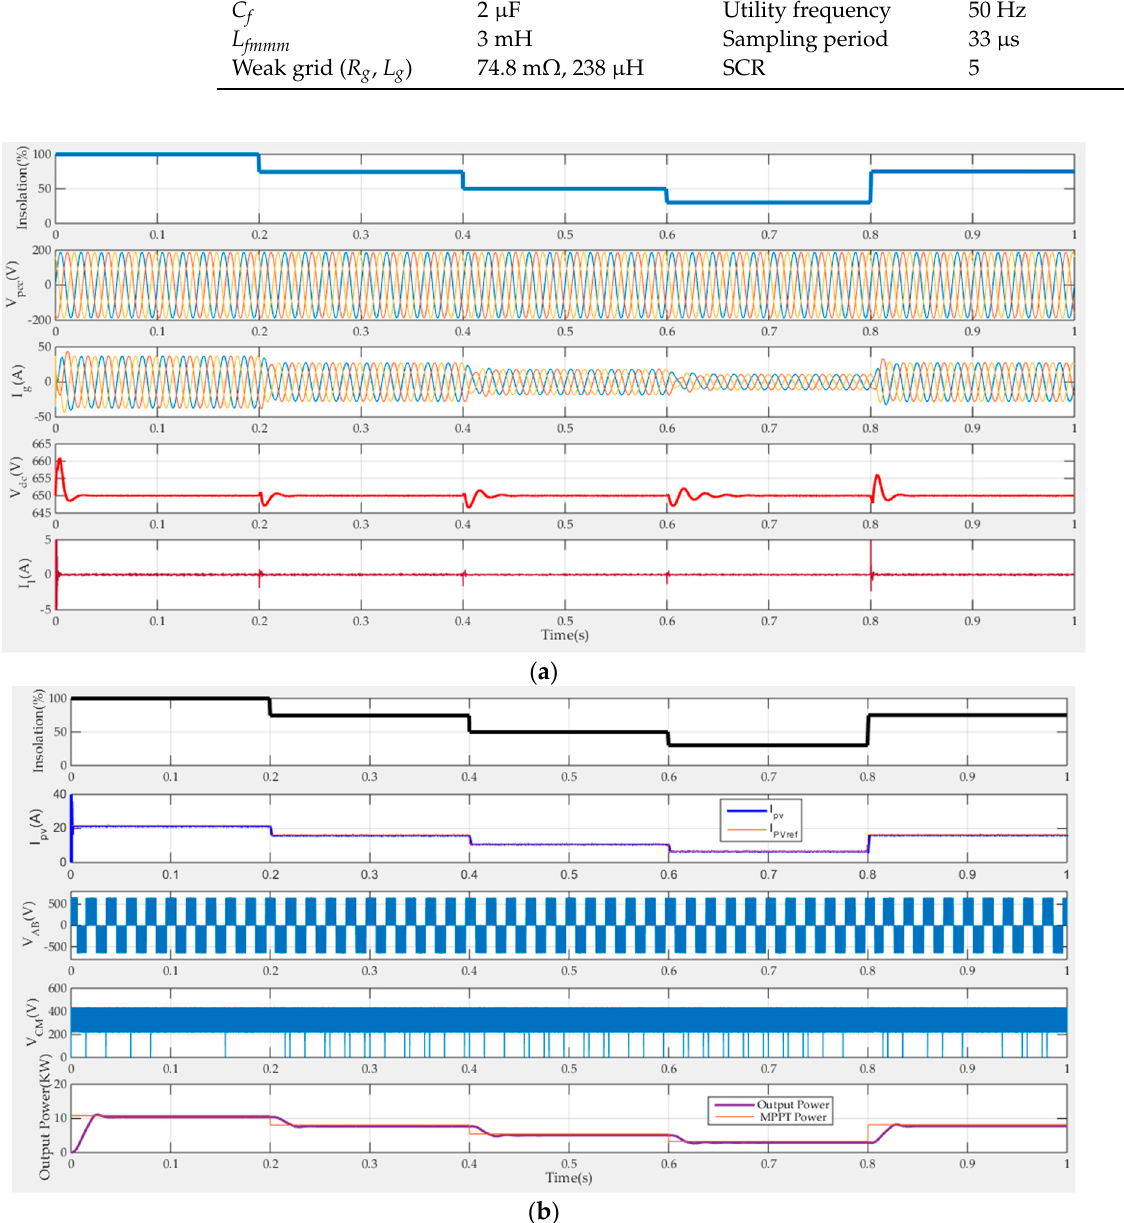
Figure 6. The response of the proposed system to step variations in the isolation level, @ strong-